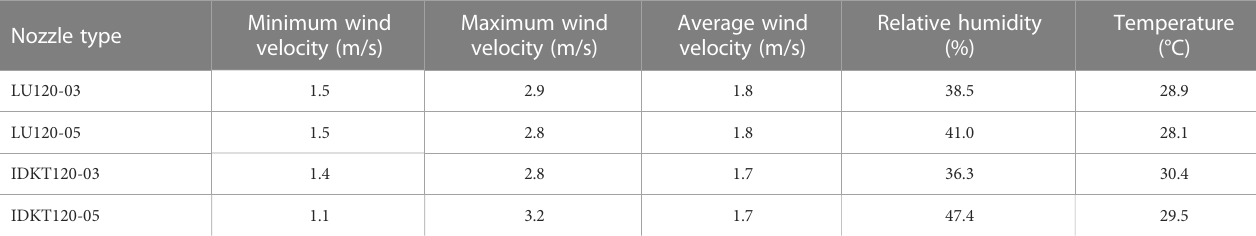
TABLE 2 Meteorological conditions during the fi eld trial. Nozzle type